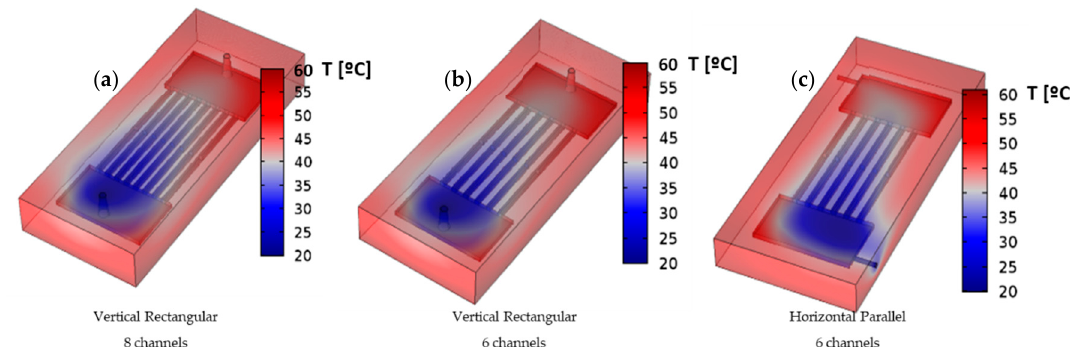
Figure 22. Temperature profiles for the studied configurations for heat transfer at a flow rate of 5 mL/min: ( a ) Vertical Rectangular with 8 channels; ( b ) Vertical Rectangular with 6 channels; ( c ) Horizontal Parallel with 6 channels.